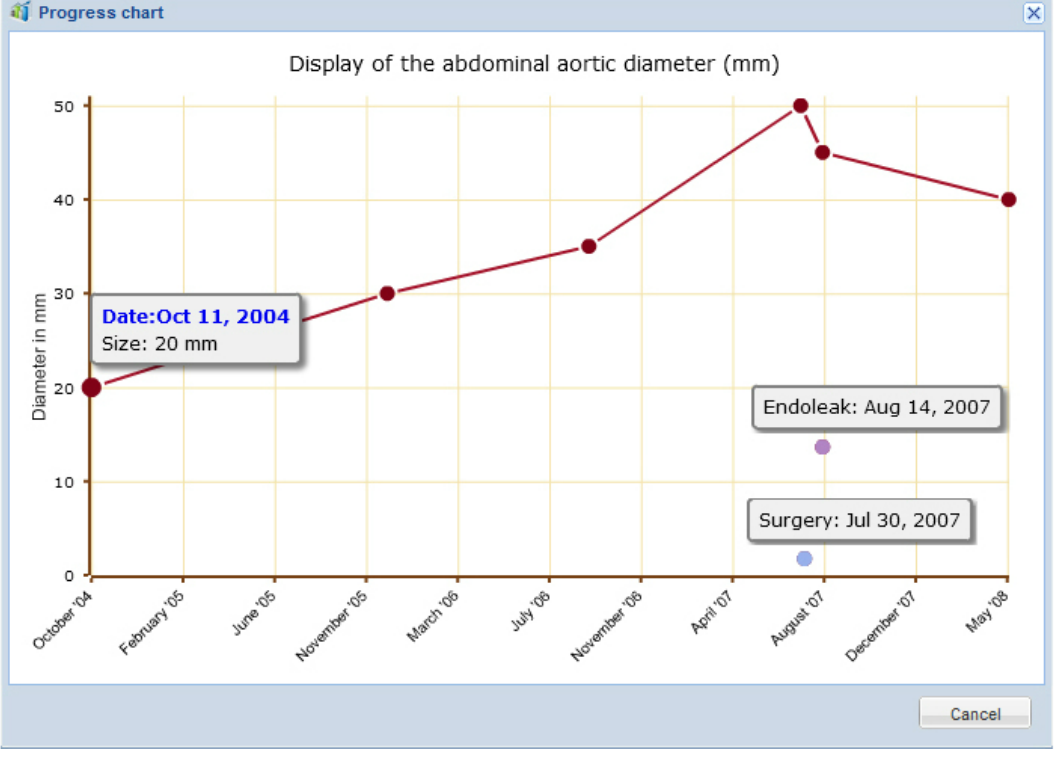
Figure 3. Example of a graph for progress-monitoring for an AAA, including the respective dates of the certain aortic diameter, surgeries, and endoleaks.